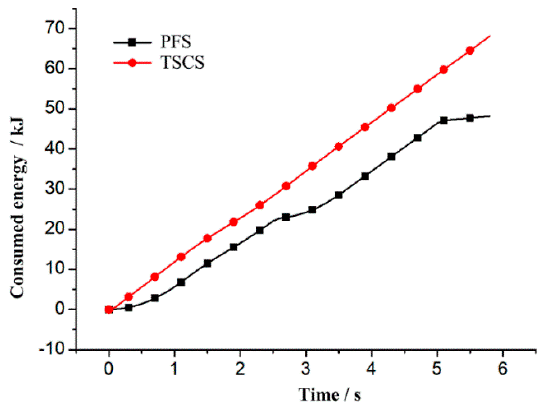
Figure 11. Energy consumption curves of the pump in the two systems.